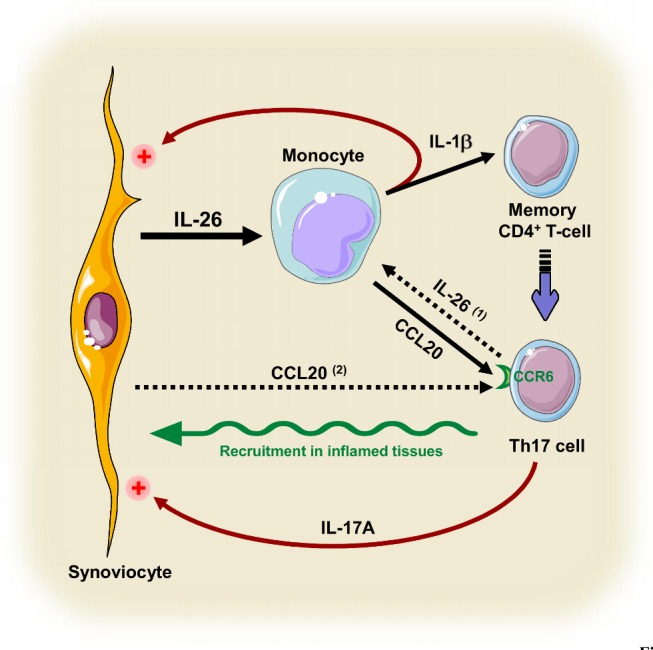
Schematic of the role of IL-26 in the Th17 cell polarization in RA.In inflamed RA joints, IL-26 is constitutively produced by synoviocytes and upregulates IL-1-beta and CCL20 secretion by myeloid cells. IL-1-beta favors the polarization of infiltrating CD4+ memory T cells into Th17 cells, and CCL20 promotes the recruitment of CCR6+ Th17 cells. In parallel, IL-1-beta and IL-17A, produced by monocytes and Th17 cells, respectively, increase IL-26 secretion by synoviocytes. IL-26 secreted by Th17 cells [1],[22] may also contribute to the production of proinflammatory cytokines by monocytes. Moreover, CCL20 produced by activated FLS may also contribute to local inflammation by inducing the recruitment of pathogenic Th17 cells in the synovium [2],[39]. This scheme was drawn using pictures from Servier Medical Art.